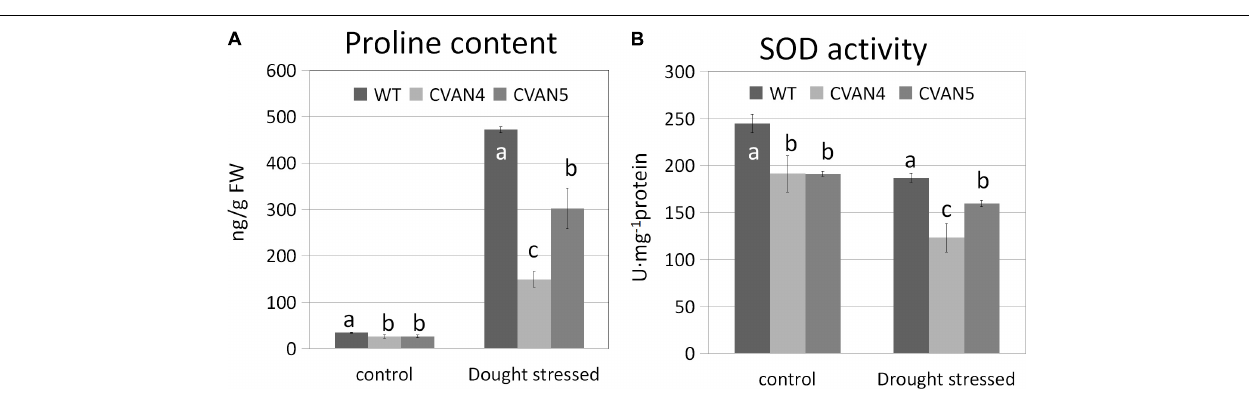
FIGURE 7 | Proline (A) and SOD (B) contents in the WT and transgenic plants on days 0 and 6 under dehydration treatment. Values are means ± SD for three independent experiments. Values with the same letter are not significantly different compared to the WT under the same condition according to Duncan’s multiple range tests ( P <